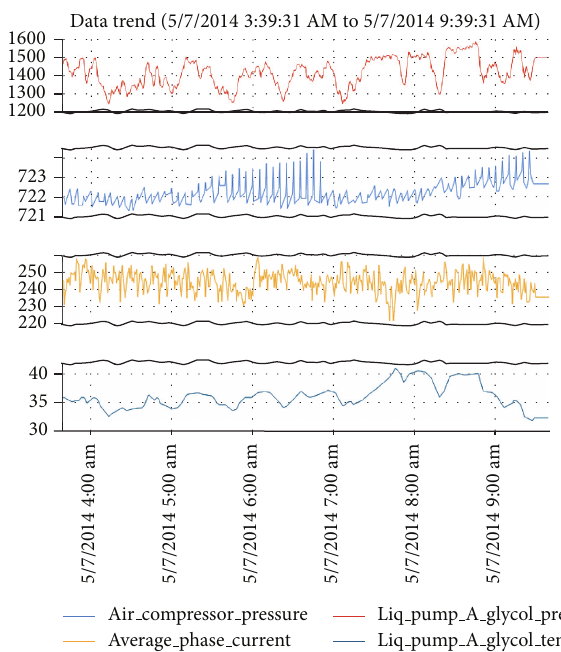
Figure 7: Runtime events data